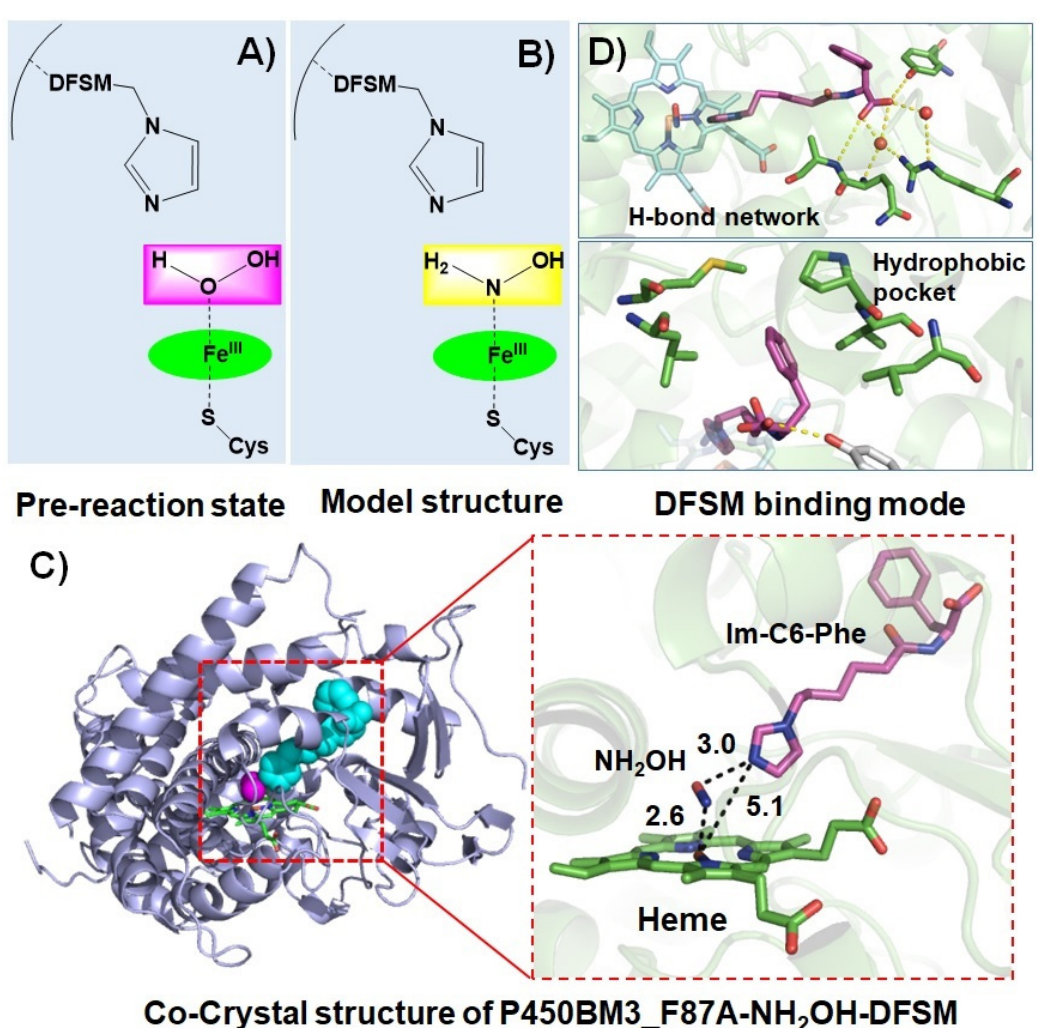
Figure 4. Structural basis of the DFSM-facilitated P450 peroxygenase. ( A ) Proposed pre-reaction state of P450BM3 in the presence of H 2 O 2 and DFSM. ( B ) The model structure with NH 2 OH instead of H 2 O 2 . ( C ) The co-crystal structure of P450BM3_F87A in complex with NH 2 OH and Im-C6-Phe. ( D ) The binding interactions of Im-C6-Phe with P450BM3.